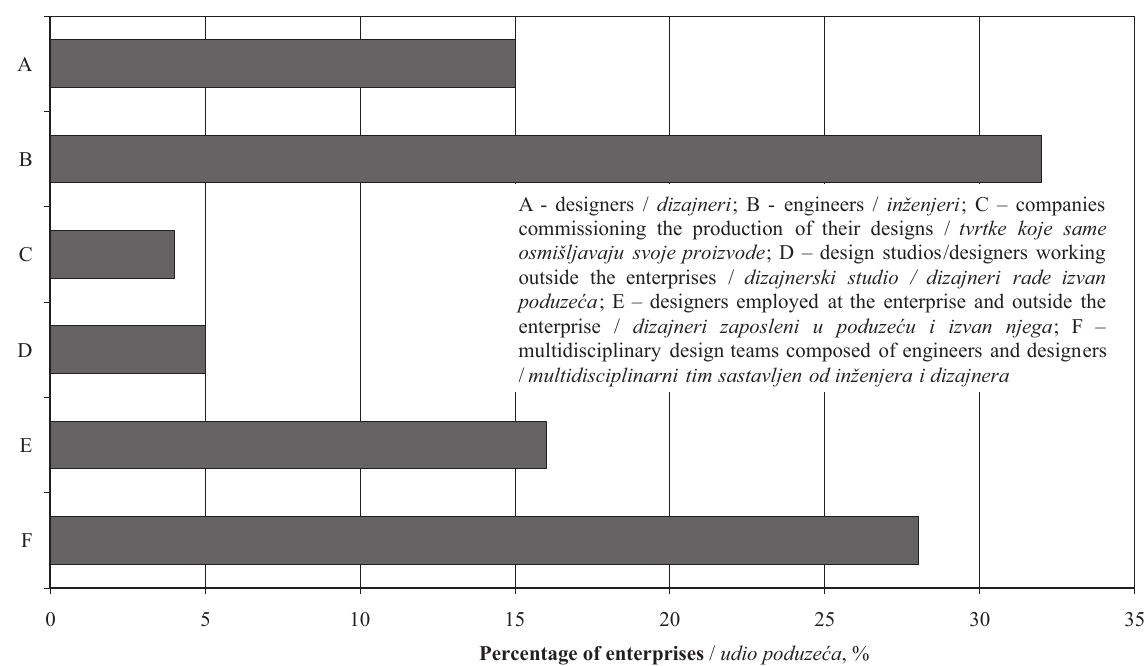
Figure 3 Structure of analysed furniture manufacturers depending on the group of design performers